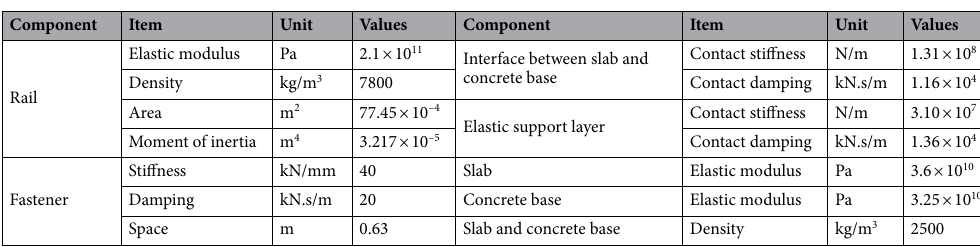
Table 2. The parameters for CRTS III slab track on subgrade